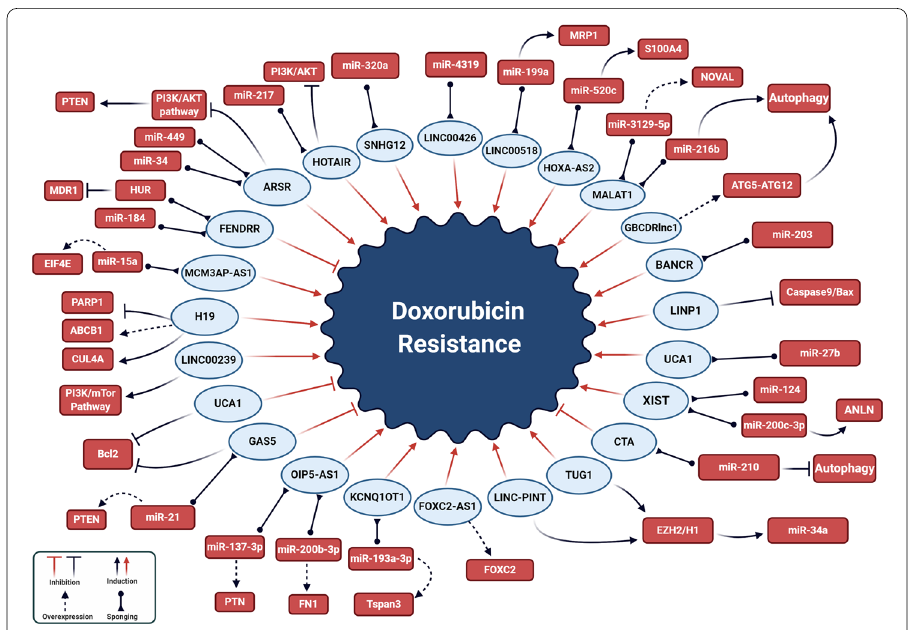
Fig. 2 The molecular mechanisms for lncRNA regulation of doxorubicin (DOX)